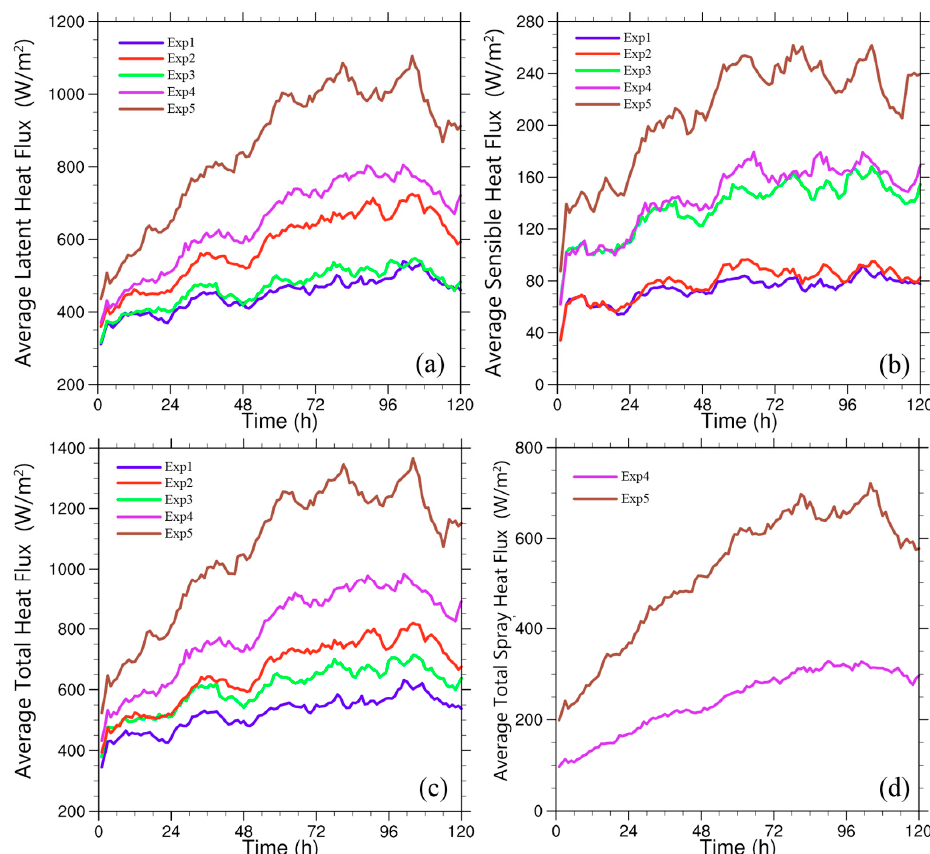
Figure 16. Average heat flux within 150 km of the TC center: ( a ) represents the air–sea latent heat flux, ( b ) represents the air–sea sensible heat flux, ( c ) represents the total air–sea heat flux, and ( d ) represents the total sea spray-induced heat fluxes. The abscissa represents the simulation time.